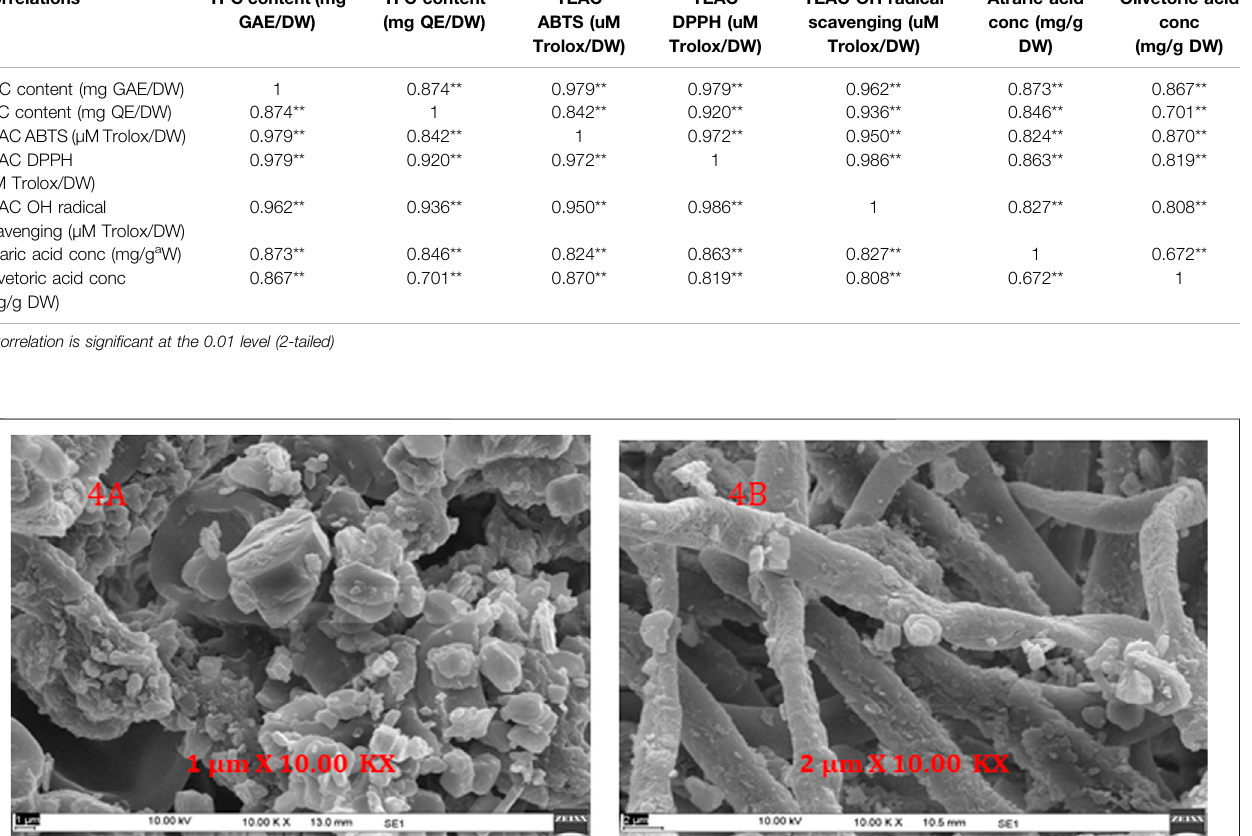
Table 1 . In the case of different solvent extraction, the maximum concentration of both the compounds were found in the 70% methanol extract, matching the trend observed in total phenolic content study. With the different extraction methods,